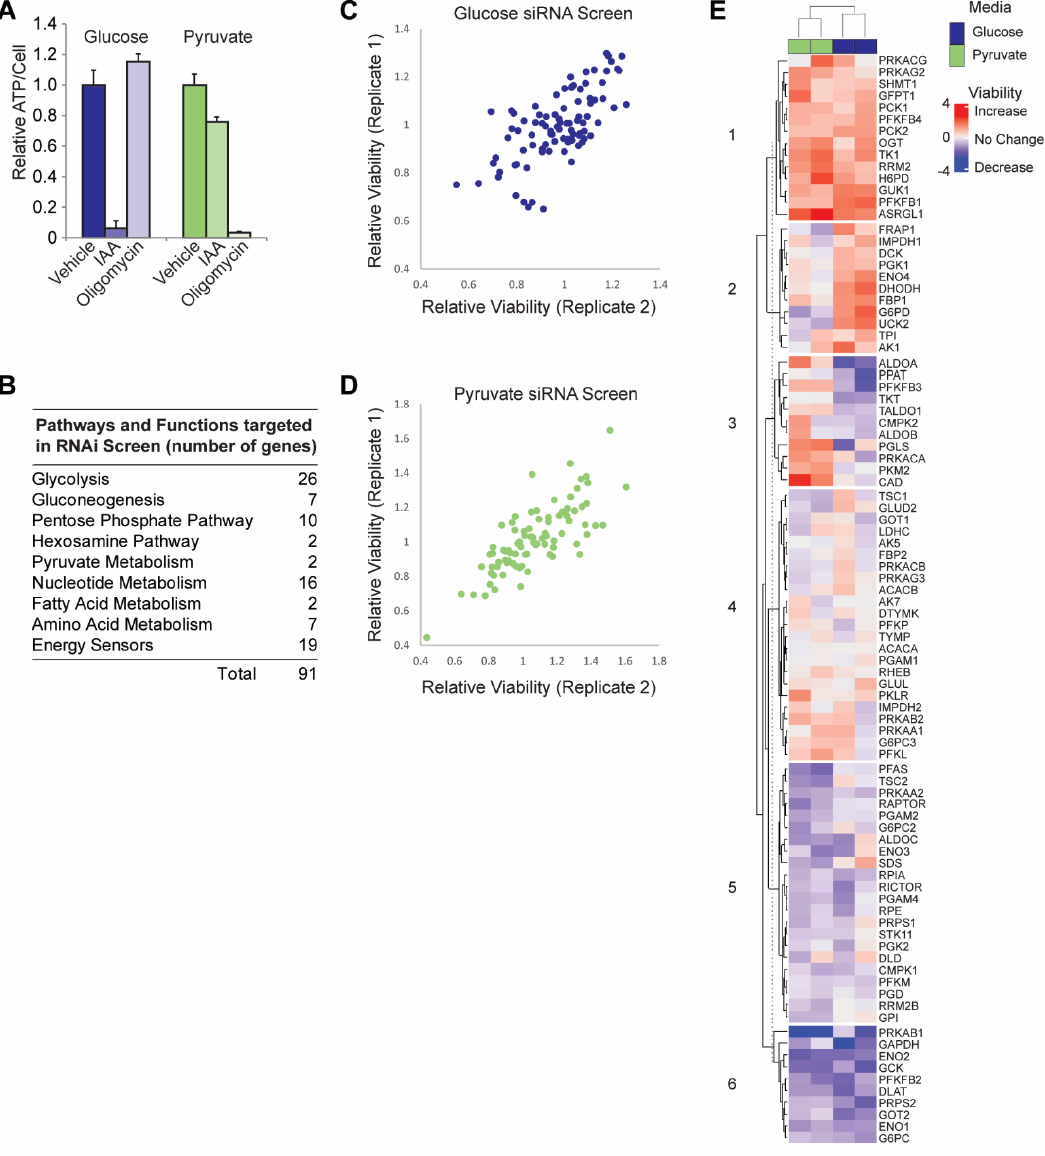
Figure 1. Metabolic-sensitized RNAi screen. ( A ) HeLa cells cultured in glucose or pyruvate were treated with a glycolytic inhibitor (IAA, 10 µ M) or an OXPHOS inhibitor (oligomycin, 500 nM) for four hours, and ATP/cell was assessed to verify unique media conditions restricting cells to either glycolytic or OXPHOS bioenergetics. ( B ) Gene categories in siRNA screen. ( C ) Relative viabilities of cells in glucose media following siRNA knockdown. ( D ) Relative viabilities of cells in pyruvate media following siRNA knockdown. ( E ) Hierarchical clustering of siRNA screen results.